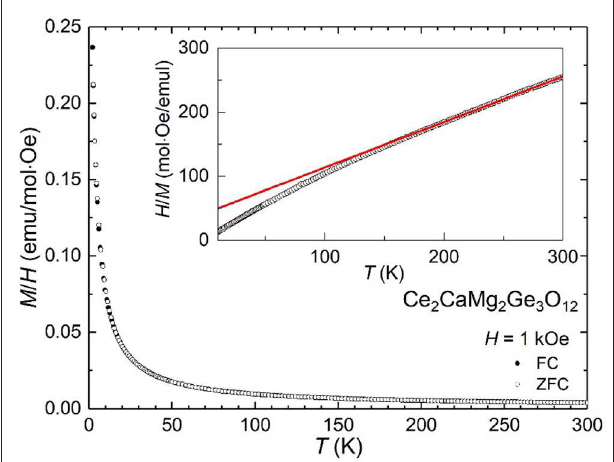
FIGURE 5 | Magnetic susceptibility of Ce 2 CaMg 2 Ge 3 O 12 , measured in a magnetic field of 1 kOe. The inset shows its inverse χ vs. T plot. The red solid line is the fit to the Curie-Weiss law.